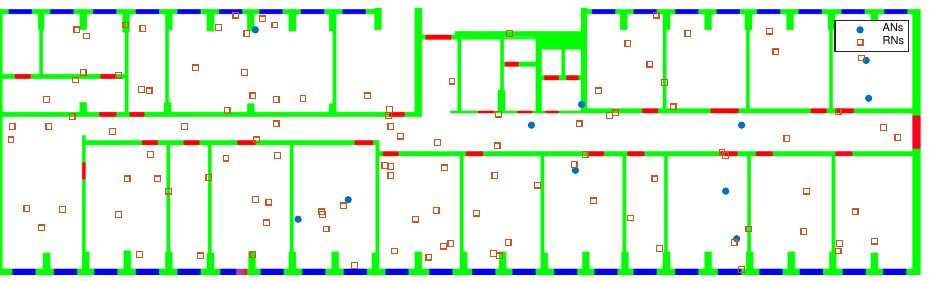
Figure 2. Example of anchor node/target node (AN/RN) Poisson point process (PPP) topology @ DIET Department; L = 10 and N = 100 (ANs: circles; RNs: